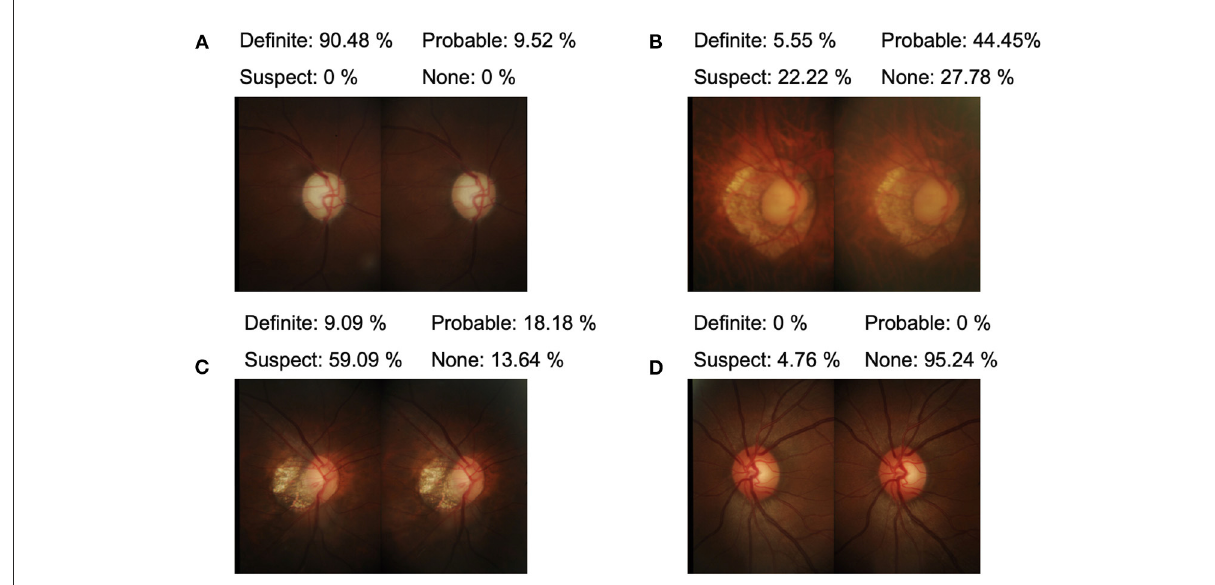
FIGURE4 Examples of representative optic disc photographs of various glaucoma likelihood (A) , definite glaucoma; (B) , possible glaucoma; (C) , probable glaucoma; (D) , none glaucoma. The distribution of gradings is shown above corresponding